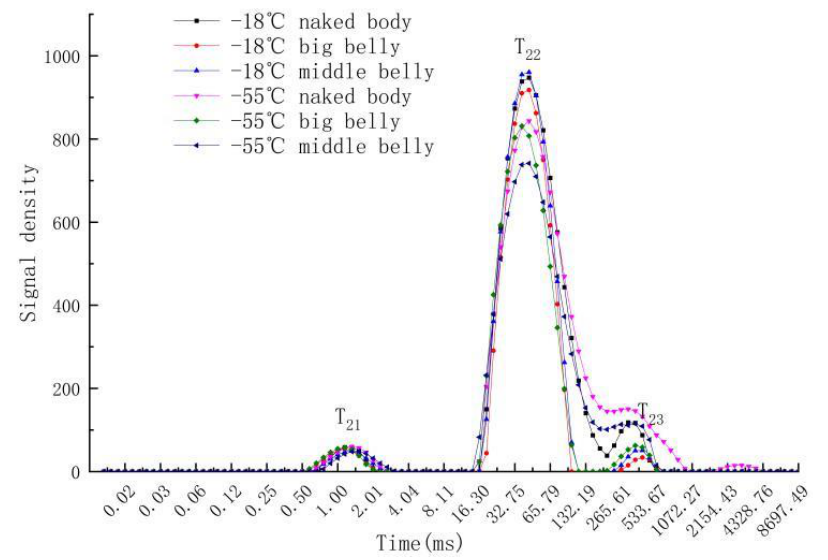
Figure 6. Changes in lateral relaxation time in different parts of tuna under different temperatures.